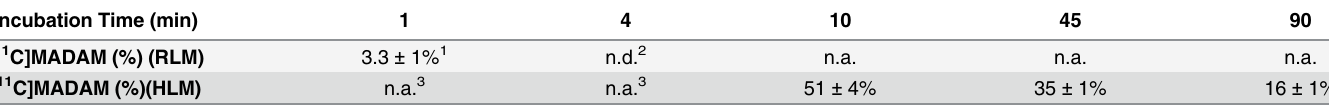
Table 1. Percentages of unchanged [ 11 C]MADAM at various time points after incubation with either rat (RLM) or human (HLM) liver microsomes.